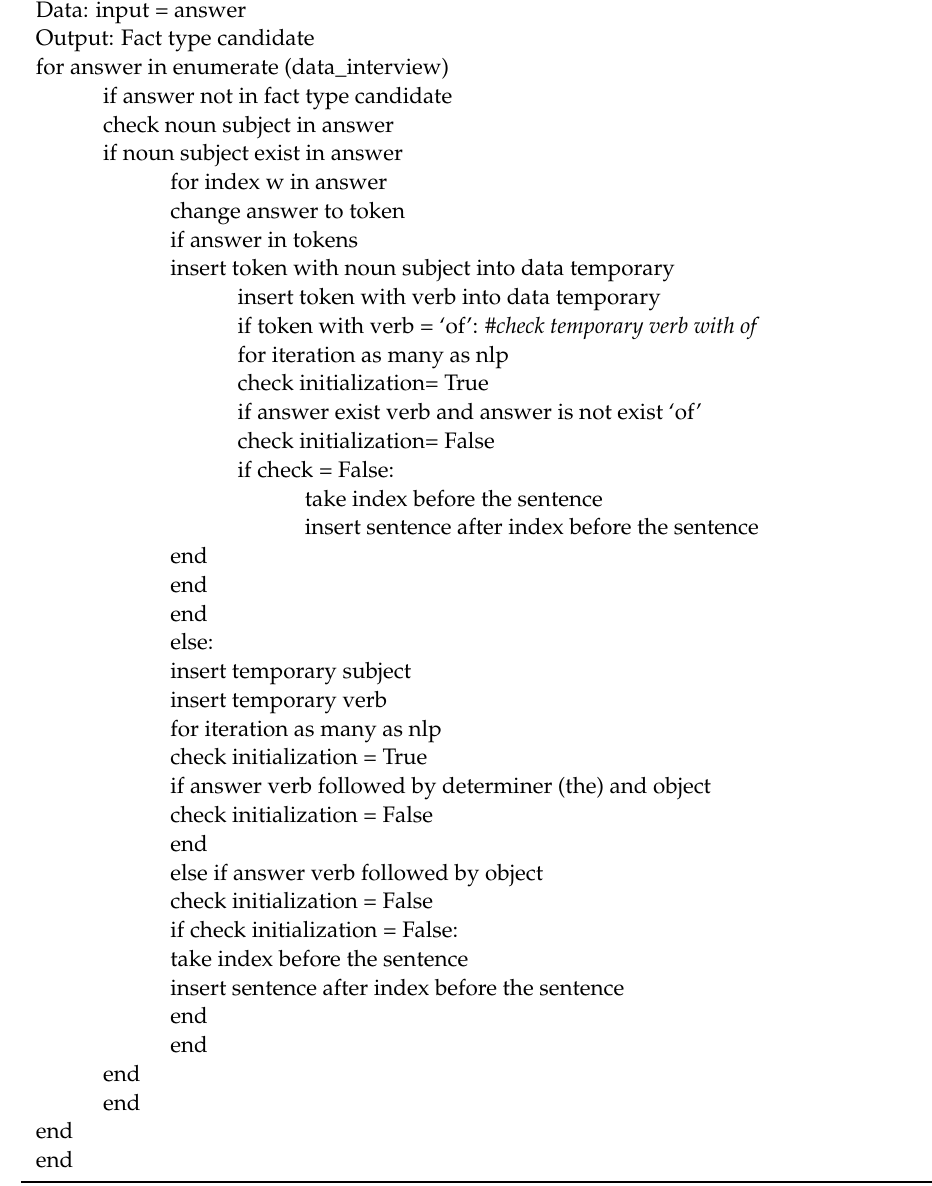
Algorithm 2. Fact type candidate based on triplet